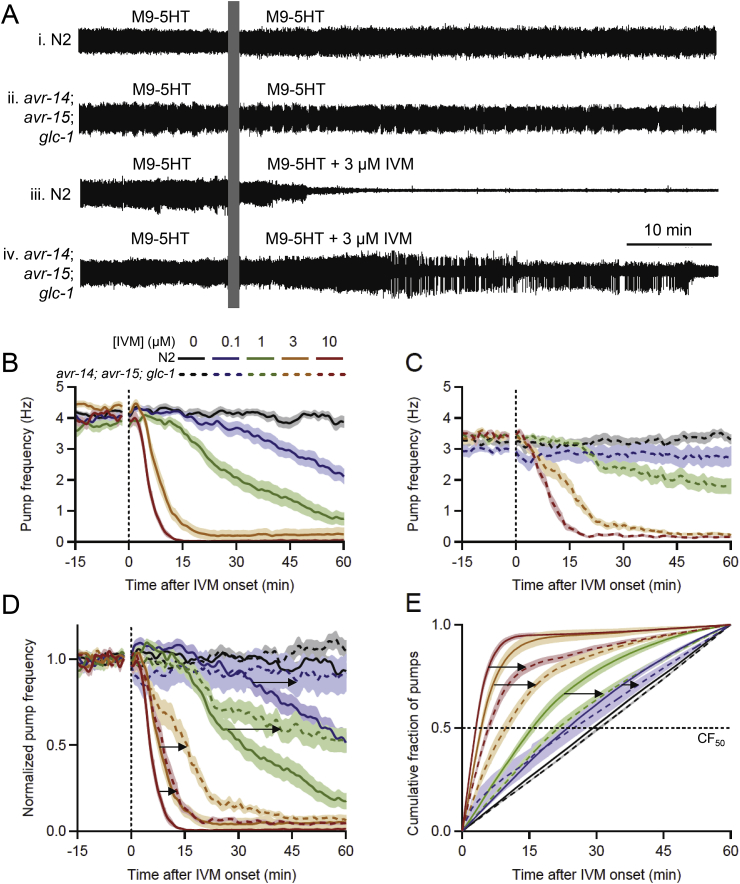
avr-14; avr-15; glc-1 (IVM-resistant) worms are less sensitive to IVM than N2s. A. Representative EPG recordings from individual worms, all perfused with M9-5HT during the baseline period. Vertical bar masks electrical artifact when the perfusate was switched. i, ii, N2 and avr-14; avr-15; glc-1 worms switched to M9-5HT (controls); iii, iv, N2 and avr-14; avr-15; glc-1 worms switched to 3 μM IVM in M9-5HT. IVM inhibited pumping more strongly in N2 than avr-14; avr-15; glc-1. B, C. Pump frequency plotted against time for N2 (B) and avr-14; avr-15; glc-1 (C) worms switched at t = 0 min to different concentrations of IVM (mean ± S.E.M.; n = 14–35 worms/group). The key in B applies to all panels; IVM concentration is denoted by color and genotype by line type (solid, N2; dashed, avr-14; avr-15; glc-1). Perfusate switch occurred at the vertical dotted line, with the electrical artifact blanked. IVM caused concentration-dependent inhibition of pumping in both strains. D. Same data as in B and C, displayed together after normalizing pump frequency to its mean value between t = −12 to −2 min within each worm, to correct for different baseline frequencies (see Section 2.6). Pump frequency plots were right-shifted (arrows) in avr-14; avr-15; glc-1 relative to N2 worms at each IVM concentration, indicating resistance. E. Same data, plotted as the cumulative fraction (CF) of pumps occurring over time after perfusate switch at t = 0 min, for each strain and IVM concentration. Dotted line denotes CF50, the intercept at which statistical comparisons were made. CF50 median values were (N2, avr-14; avr-15; glc-1, respectively, in minutes): 0 μM IVM, 30.8, 29.5; 0.1 μM IVM, 29.6, 26.0; 1 μM IVM, 15.0, 21.2; 3 μM IVM, 4.3, 10.9; and 10 μM IVM, 3.0, 6.0. Arrows denote rightward shifts of CF plots in avr-14; avr-15; glc-1 vs. N2 worms. (For interpretation of the references to color in this figure legend, the reader is referred to the Web version of this article.)